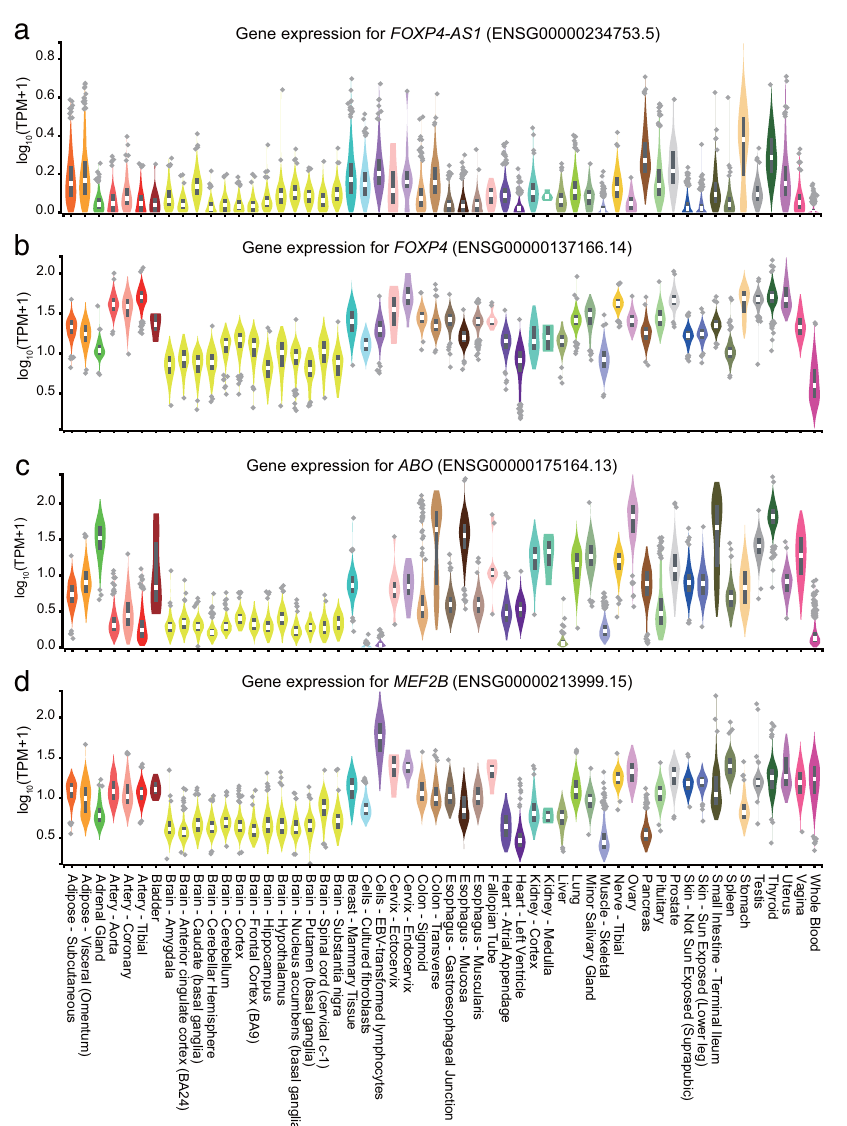
Fig. 3 RNA expression in multiple tissues for genes within signi fi cant loci. a FOXP4-AS1 . b FOXP4 . c ABO . d MEF2B . TPM, transcripts per million. This fi gure was generated by the GTEx portal Imputation . We merged our COVID-19 GSA dataset and the COW dataset by extracting 436,444 autosomal and 10,528 chromosome X SNPs genotyped in both datasets. We further excluded SNPs with MAF<0.005 in either dataset, leaving 369,072 autosomal and 8942 chromosome X SNPs for imputation. We constructed an imputation reference panel by combing the 1000 Genomes Project (1KGP) dataset 23 and our in-house WGS data of COVID-19 patients from Tongji Hospital (see the “ WGS data and analysis ” section below). We fi rst extracted the intersecting variants of 1KGP and our WGS dataset and used EAGLE2 (v 2.3.5) to phase our WGS samples with haplotypes from 1KGP as the reference 60 . We then combined the phased haplotypes of our WGS samples and the East Asian samples from 1KGP to form a reference panel to phase and impute our array genotyping datasets. Imputation was performed using Minimac4 61 . For the X chromosome, pseudo-autosomal regions (PARs) were excluded and non-PARs were imputed separately for males and females. After removing variants with MAF< 0.01 and imputation R 2 <0.8, 6,019,210 autosomal variants and 132,535 on the X chromosome remained for downstream analyses. Cryptic relatedness and population structure . We fi ltered variants with MAF< 0.05, and pruned the merged COVID-19 and COW genotyping data to have linkage disequilibrium (LD) r 2 < 0.5, resulting in 157,968 autosomal SNPs 58 . Using this set of SNPs, we inferred genetic relatedness using KING (v 2.2.5) and determined relatedness types based on the estimated kinship coef fi cients φ and the probability of zero-IBD-sharing π 0 62 . We identi fi ed 31 fi rst-degree and 7 second-